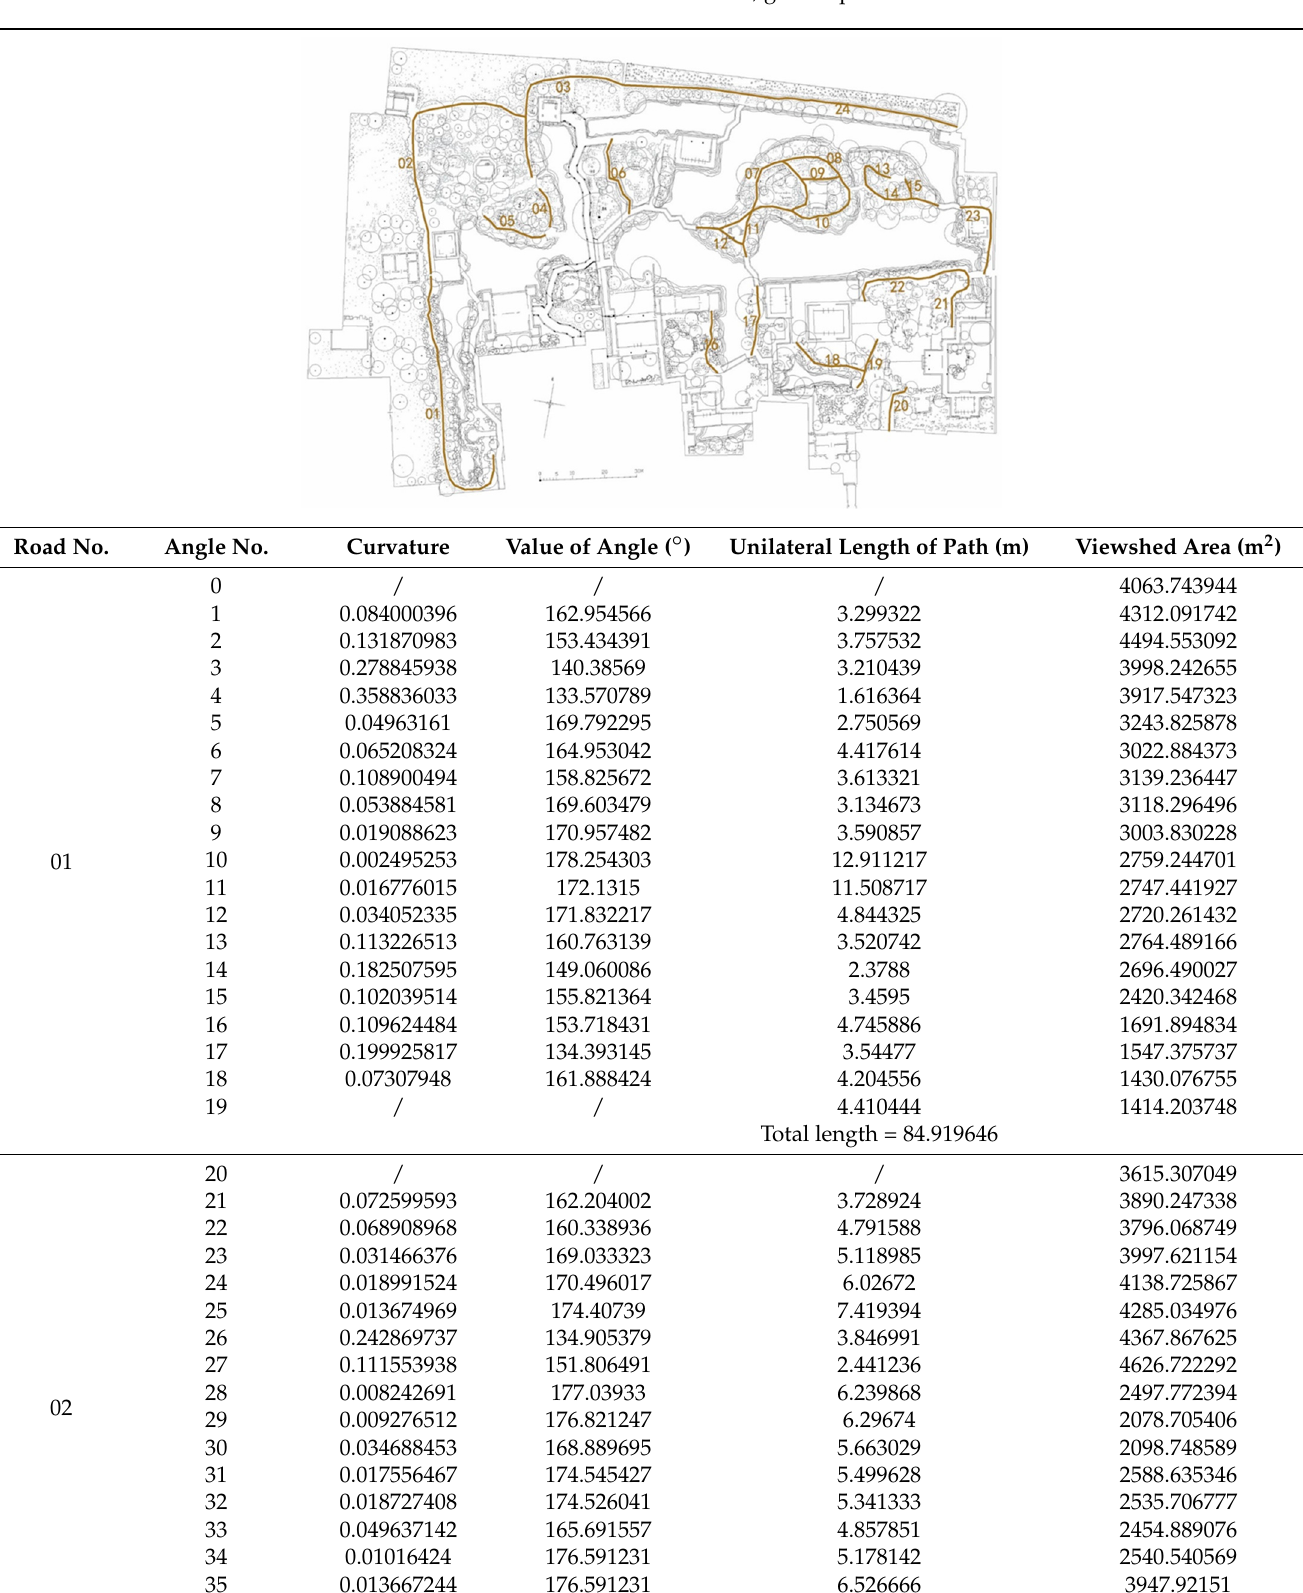
Table A2. Humble Administrator’s Garden, garden path.